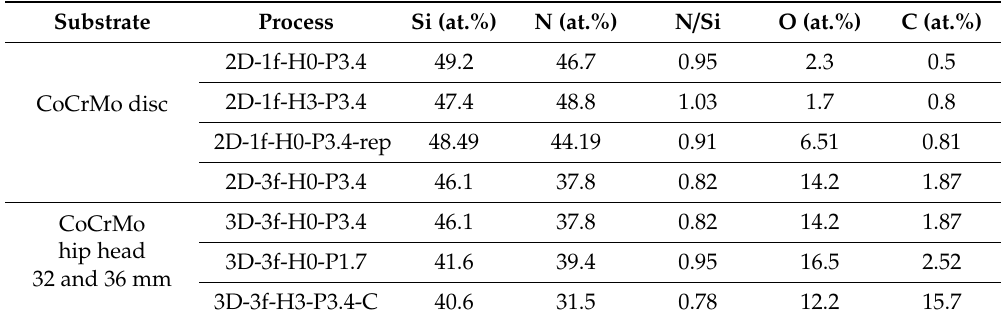
Table 2. Results from X-ray photoelectron spectroscopy analysis for 2D and 3D coatings showing silicon, nitrogen, N / Si ratio, oxygen and carbon at.%. The quantification accuracy of XPS is typically around ± 5% for elements < 10 at.% and ± 2%–3 % for elements > 10 at.%. Substrate Process Si (at.%) N